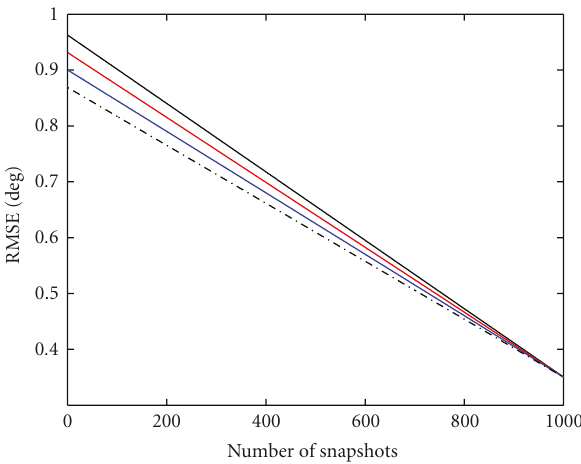
Figure 5: RMSE versus number of snapshots: Cramer-Rao bound (dashed) from [22], proposed method (blue), maximum likelihood [5] (red), and MUSIC method in [16](solid).